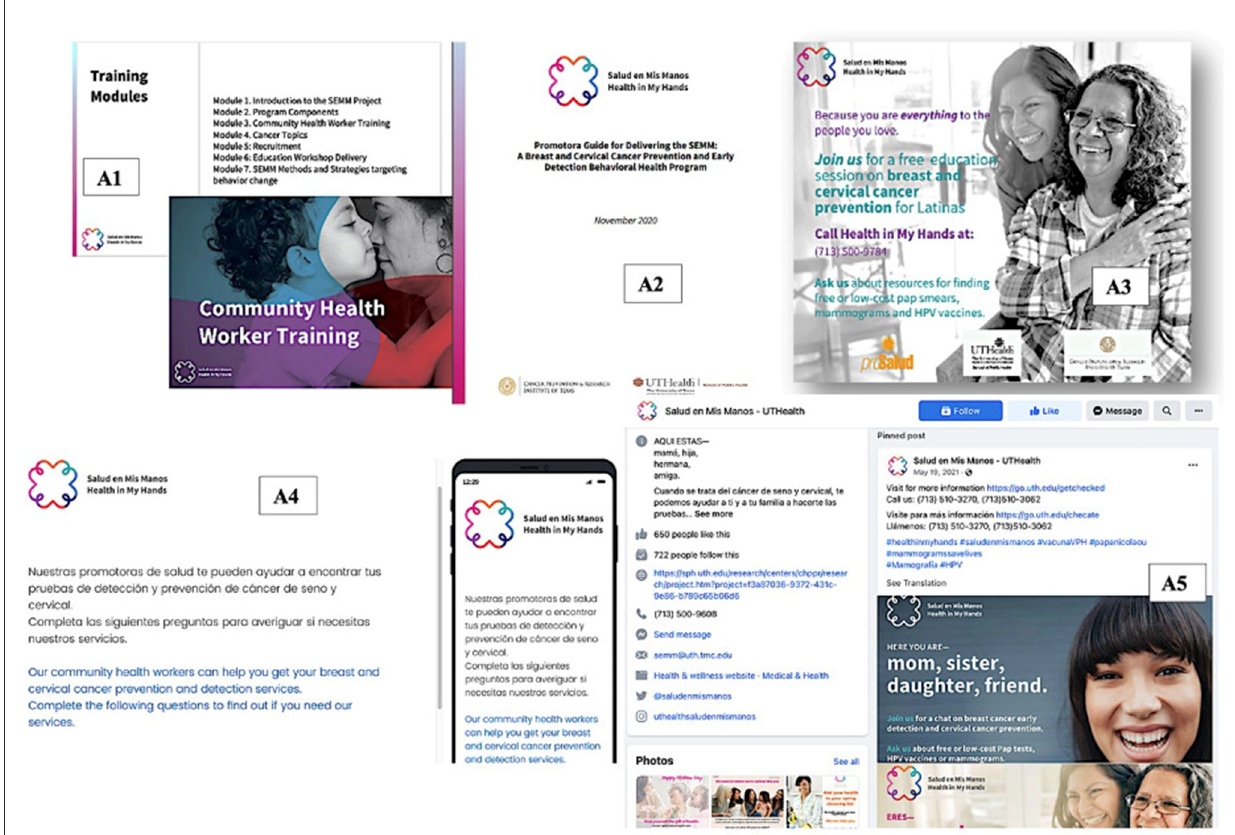
FIGURE3 Sample of existing SEMM Resources to Support CHW Training, Community Outreach, and Recruitment to the SEMM Intervention: (A1) CHW Training Curriculum, (A2) CHW Guide for Delivering SEMM Education Intervention, (A3) SEMM Promotional Print Material, (A4) SEMM Participant Needs Assessment, and (A5) SEMM Social